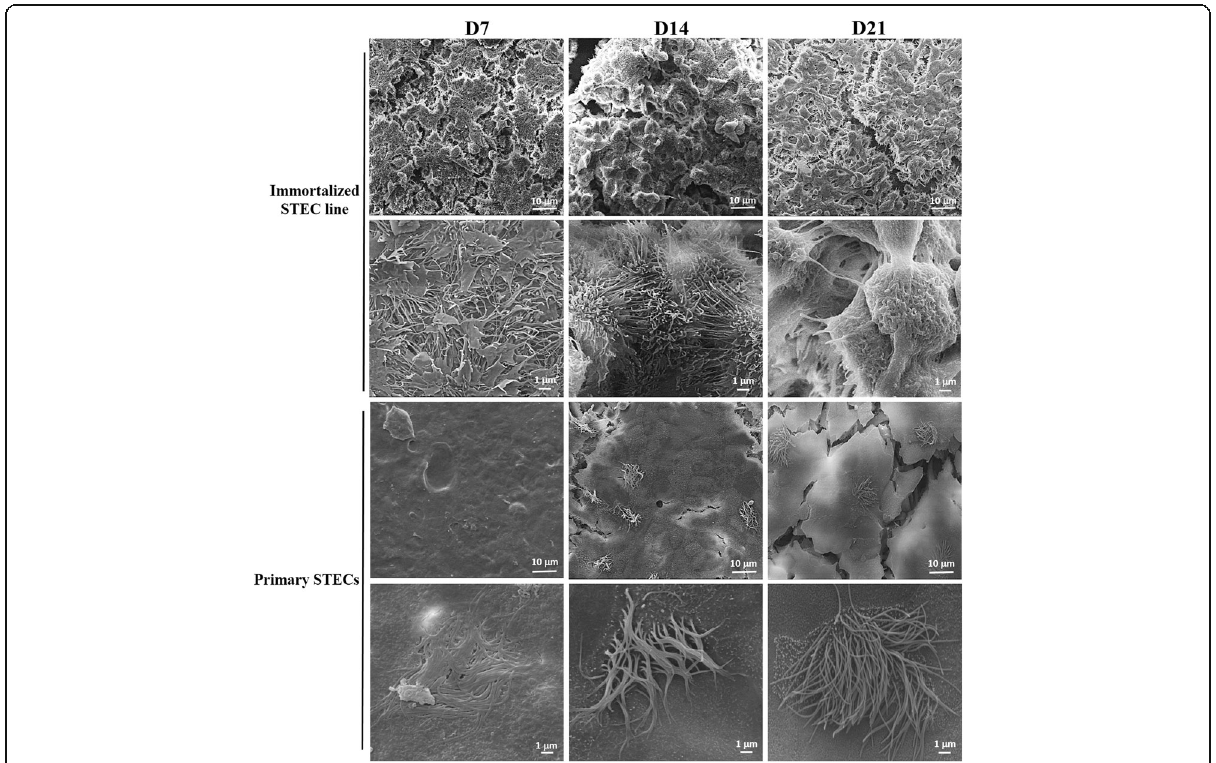
Fig. 3 Scanning electron microscopy (SEM) analysis of immortalized STEC line and primary STECs cultured under Ali conditions. Immortalized STEC line and primary STECs were cultured under Ali conditions for 21 days, and cilia differentiation on the cells was evaluated by SEM at D7,